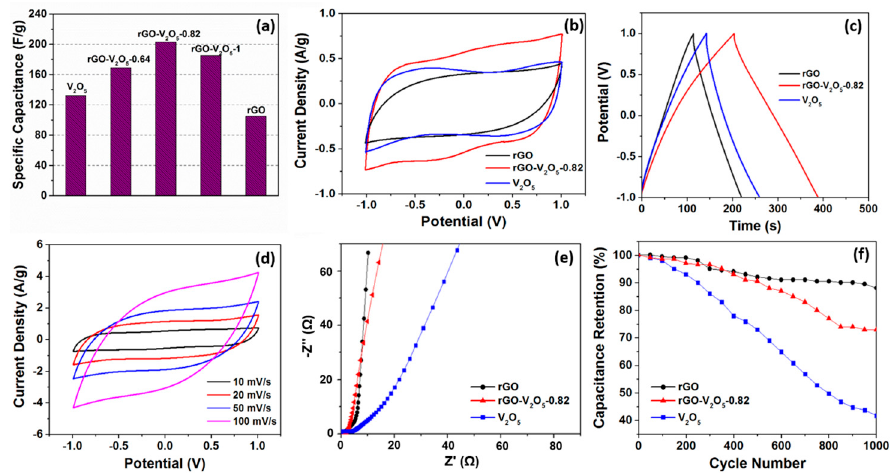
Figure 3. ( a ) Summary of specific capacitance of a series hybrid aerogels prepared by Method I as compared with pure V 2 O 5 and rGO aerogels; ( b ) cyclic voltammetry curves of the rGO-V 2 O 5 -0.82 hybrid aerogel as compared with pure V 2 O 5 and rGO aerogels at a scan rate of 10 mV/s; ( c ) galvanostatic charge/discharge curves of rGO and V 2 O 5 aerogels and the rGO-V 2 O 5 -0.82 hybrid aerogel at a current density of 1 A/g; ( d ) CV curves of the rGO-V 2 O 5 -0.82 hybrid aerogel at a varied scan rate; ( e ) electrochemical impedance spectra measured at a frequency of 0.01 HZ–100 kHZ for the rGO aerogel, the V 2 O 5 aerogel, and the rGO-V 2 O 5 -0.82 hybrid aerogel; and ( f ) cycle stability of the rGO aerogel, the V 2 O 5 aerogel, and the rGO-V 2 O 5 -0.82 hybrid aerogel.